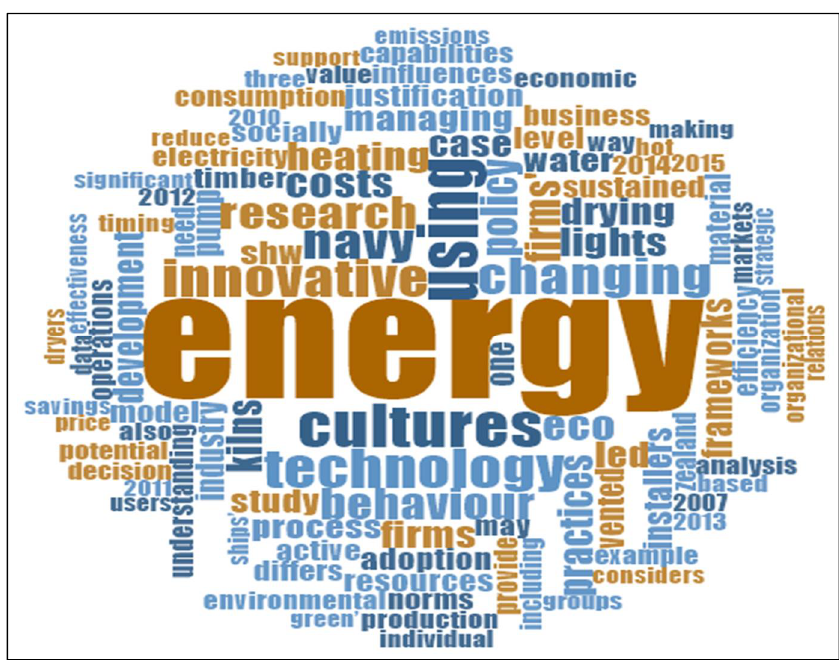
Figure 4. Word cloud analysis (Source: Outcome of the NVivo 12 word cloud analysis).